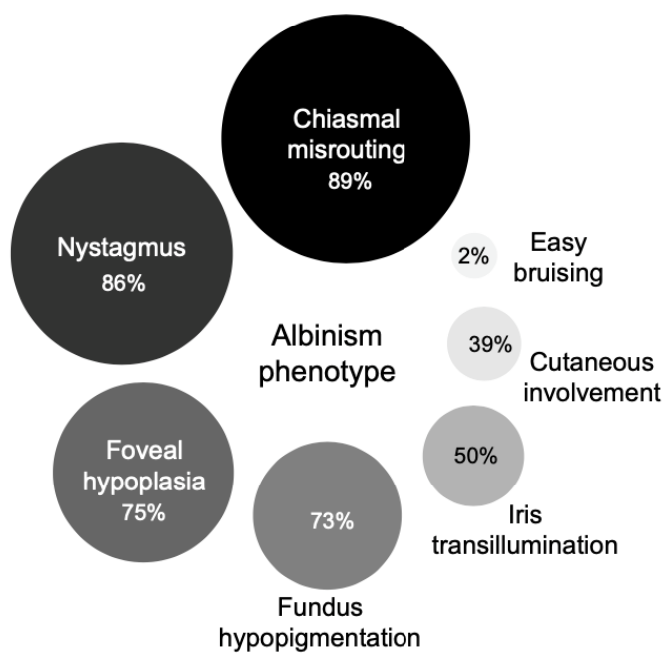
Figure 2. Overview of the phenotypic spectrum of 44 suspected albinism patients presenting to the ocular genetics service. For chiasmal misrouting, n = 37, 7 declined electrophysiology visual evoked potential (VEP) testing.